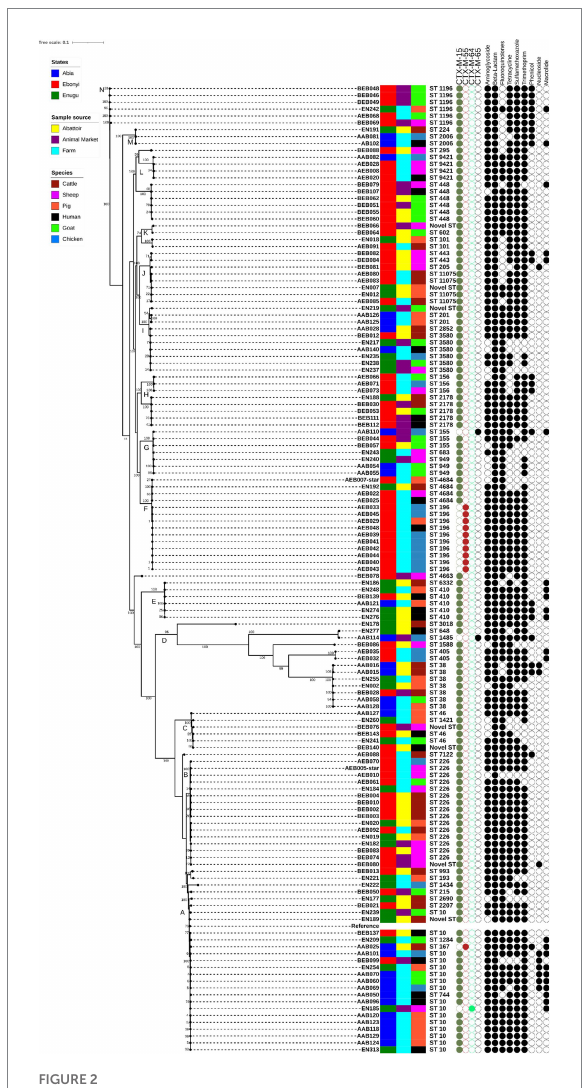
FIGURE 2 Maximum likelihood core-genome single nucleotide polymorphism (SNP) tree showing phylogenetic relatedness of 140 isolates from Southeast Nigeria. Genetic relatedness is indicated by branch length and position confidence in clades by bootstrap confidence values displayed on the tree. Also given are the multi-locus sequence type, the bla CTX-M variant and MDR profile (black circles indicated presence of at least one resistance gene variant while the white circles indicated the absence of AMR genes conferring resistance to antimicrobials tested) of each E. coli isolate, along with the state, sample source, and host animal. Escherichia coli K-12 was used as the reference genome in building the